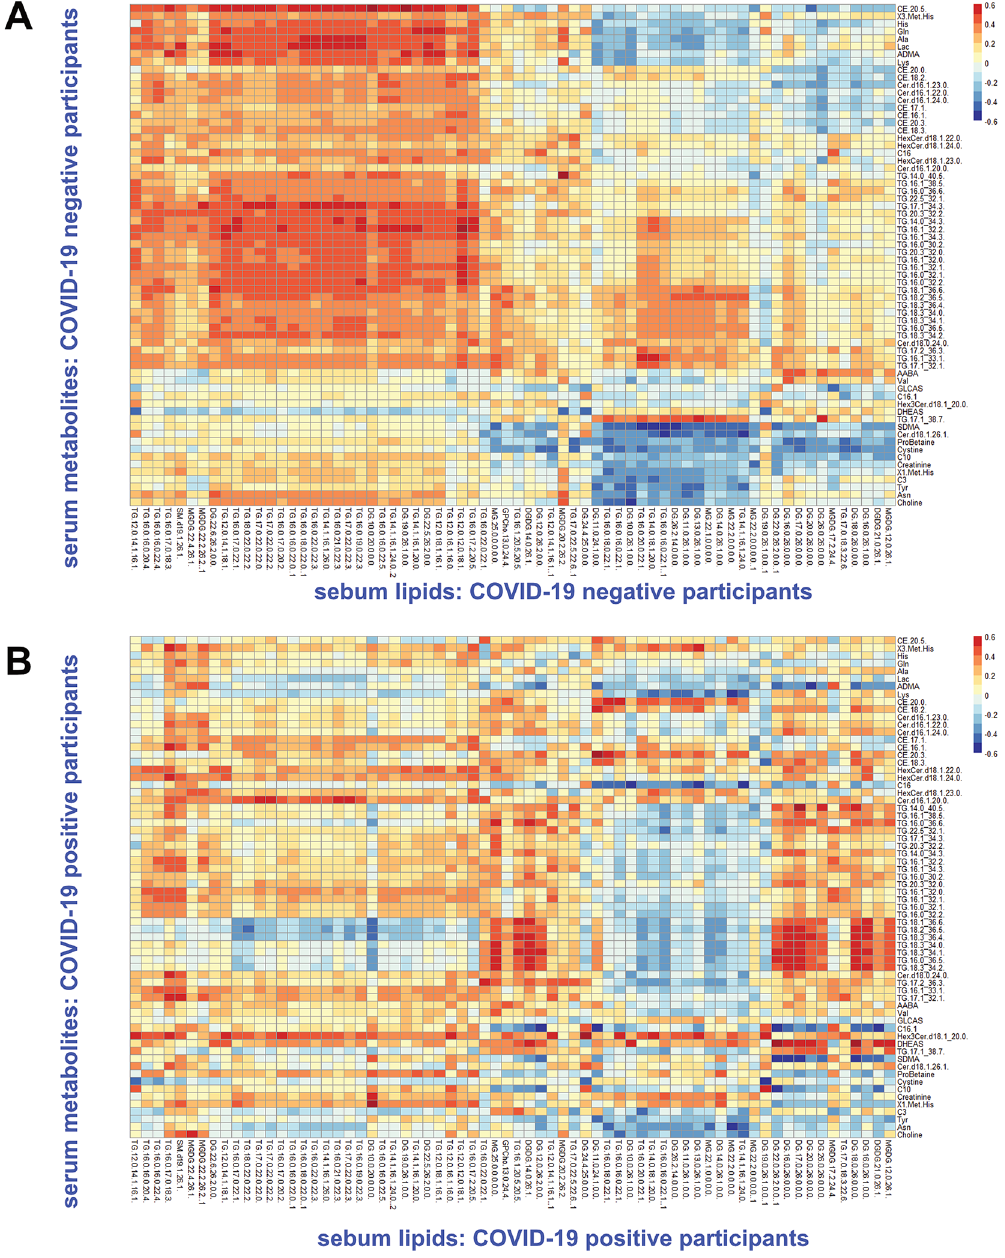
Figure 2. Heatmaps showing Pearson correlation coefficients between sebum lipids and serum metabolites sampled from study participants: COVID-19 negative participants ( A ) and COVID-19 positive participants ( B